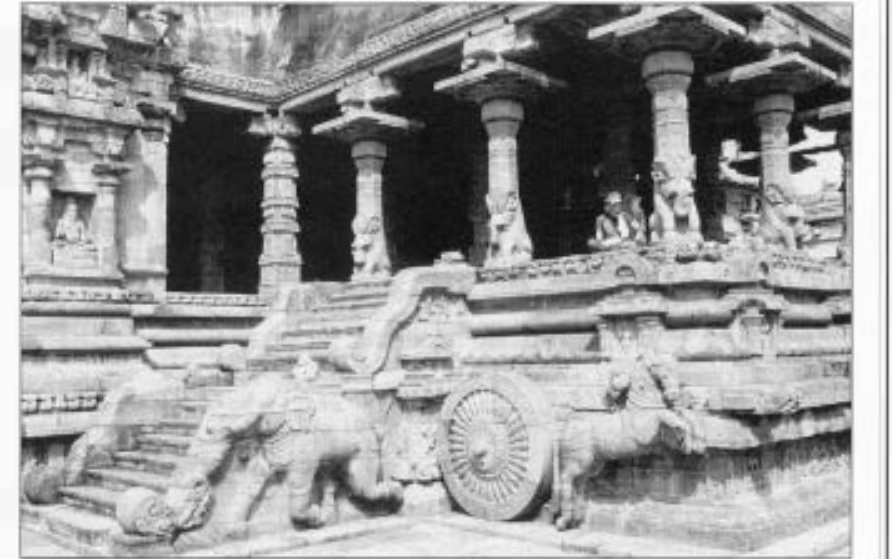
Figure 6 The Airavateshvara temple, Darasuram: the southern portico sculpted to depict a celestial chariot drawn by horses and